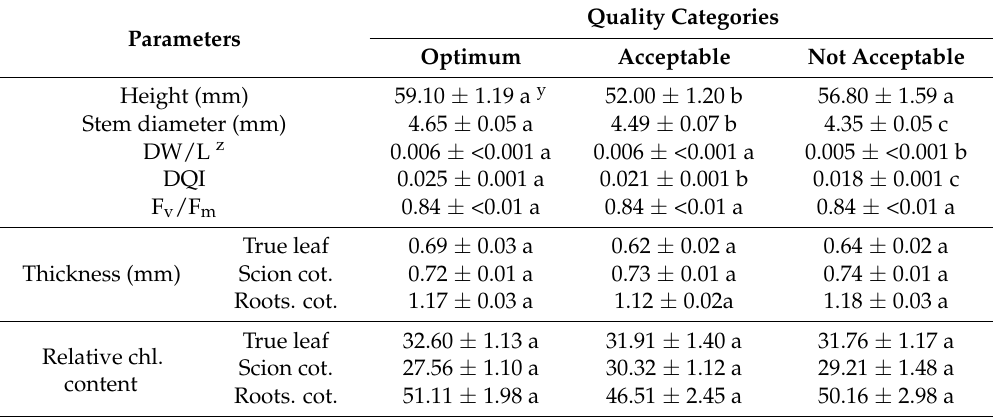
Table 4. Morphological and developmental parameters of grafted watermelon seedlings from two quality categories 14 days after grafting.